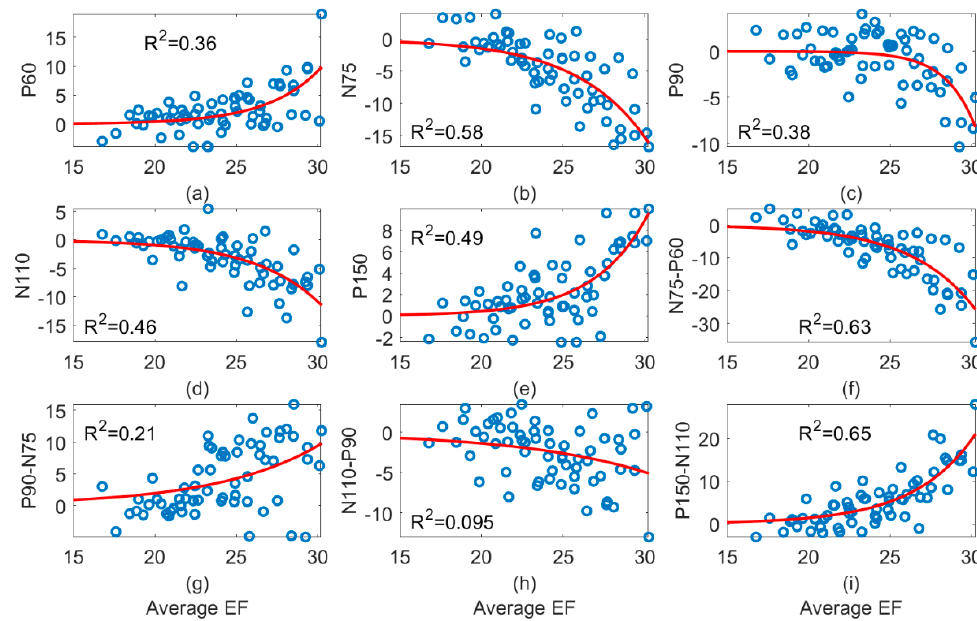
Figure 8. ( a – e ) Exponential model fits of the TEP components vs. the average E-field value, and the difference of successive components values ( f – i ). The adjusted R 2 for each model fit is shown inside each panel.